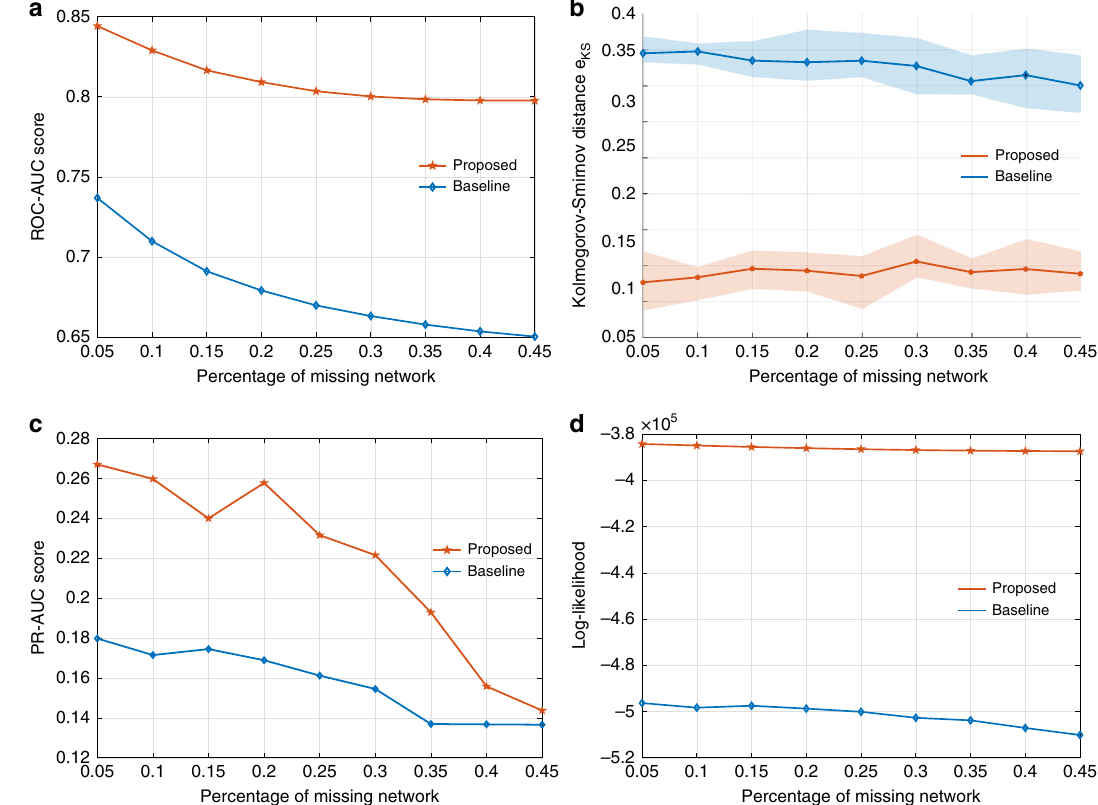
Fig. 6 Evaluation of the capability to recover the Facebook social network ( α = 1). a , c Compare the capability to infer the missing network via AUC scores. b Goodness-of-the- fi t comparison as reported by Kolmogorov – Smirnov distance between the true degree distribution and the one retrieved by baseline and proposed methods. d Quanti fi cation of the capability of both methods to recover the global property of the example social network via log-likelihood